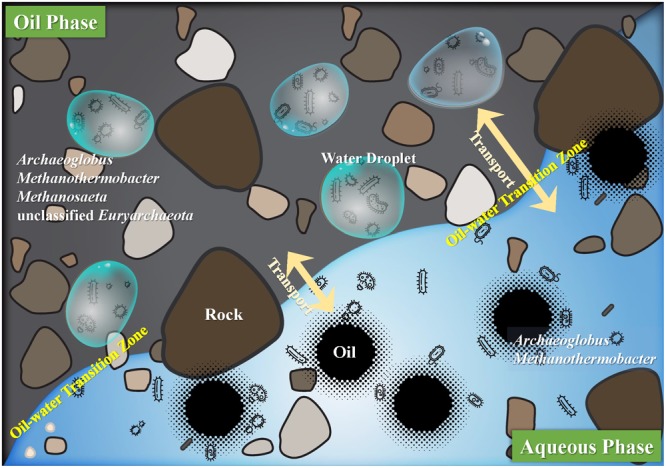
Hypothesized outline of oil and aqueous phases in the deep subsurface petroleum reservoirs. Interface of the oil and aqueous phases showing the oil–water transition zone where water droplets and oil droplets can transport to each other. And these droplets constitute the microscopic habitats where microorganisms interacted with the substrates. In the aqueous phase, microorganisms inhabit in the liquid water or around the oil droplets, and in the oil phase microorganisms inhabit only in the minuscule water droplets. Microorganisms showing in oil and aqueous phase represent the core archaea that appeared in the four production wells.